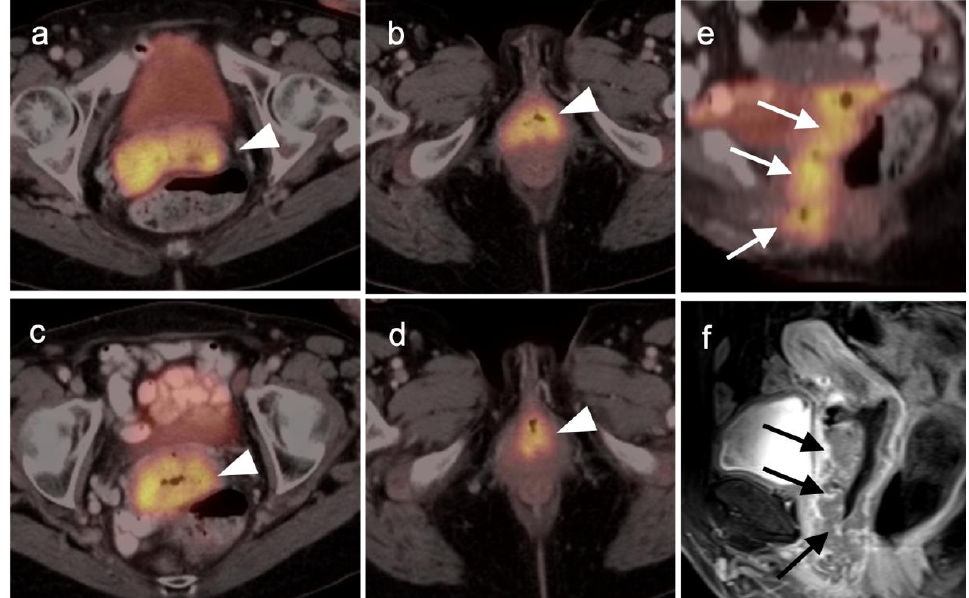
Figure 17. Stage IIIA cervical cancer by FDG PET-CT and MRI. ( b – d ) Axial FDG PET-CT demonstrates extension of cervical cancer throughout the entire vagina (white arrowheads). ( e , b ) Sagittal views of the pelvis shows cervical cancer spread throughout the entire vagina by FDG PET-CT ( e , white arrows) and MRI ( f , black arrows).